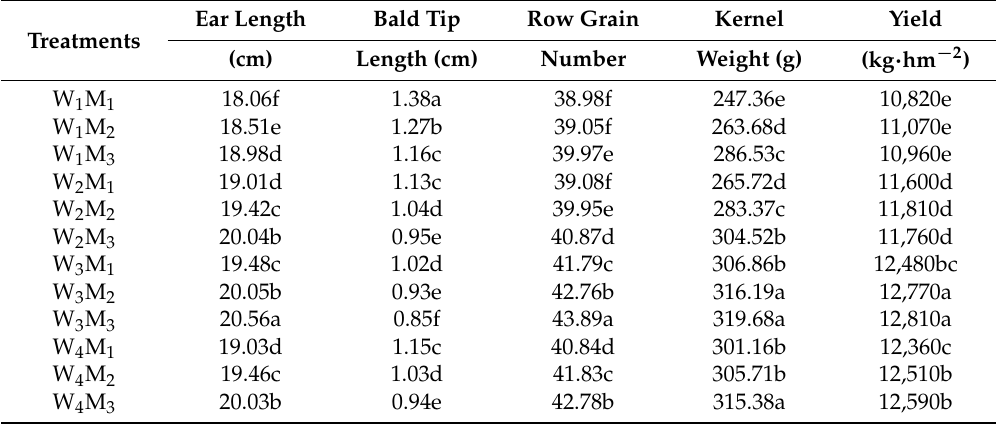
Table 7. Effect of irrigation amount on yield and components of biodegradable film covered with drip-irrigated